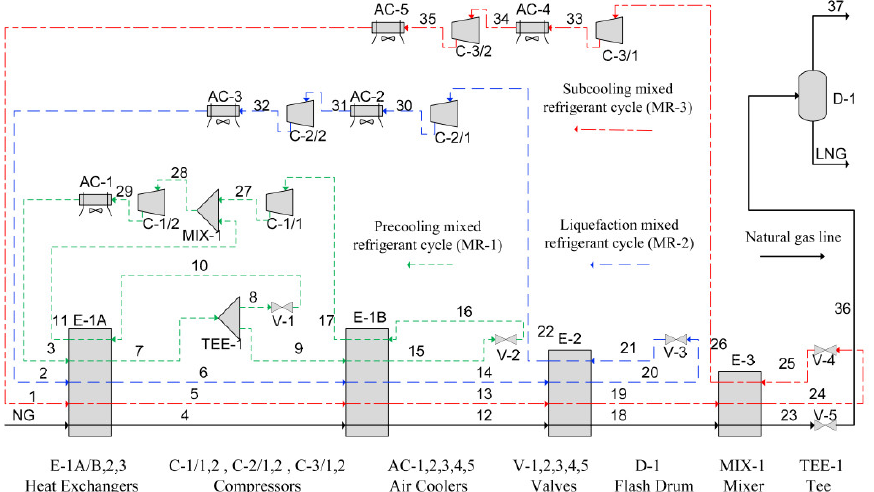
Figure 7. Process flow diagram of mixed fluid cascade [39]. Reproduced with permission from Wiley Online Library (license number